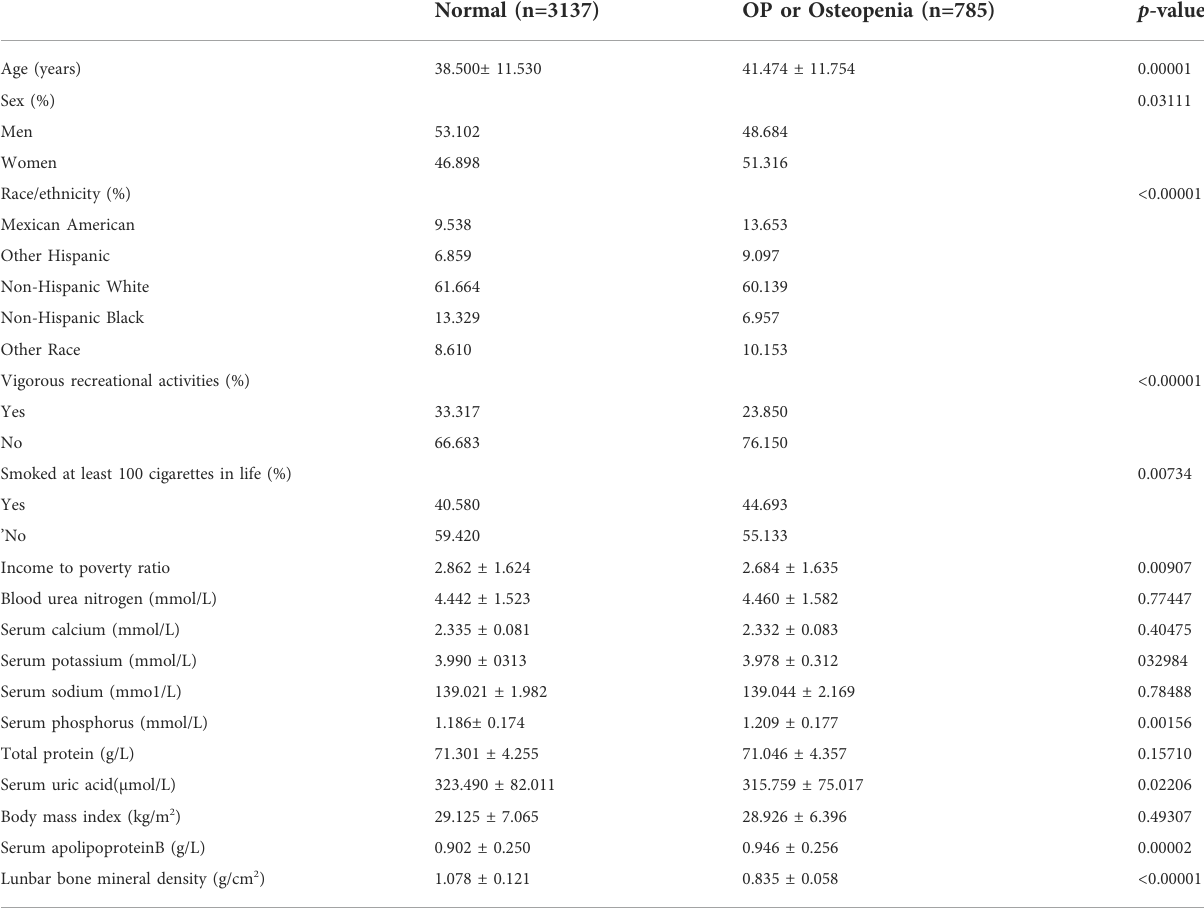
TABLE 1 Weighted characteristics of the study